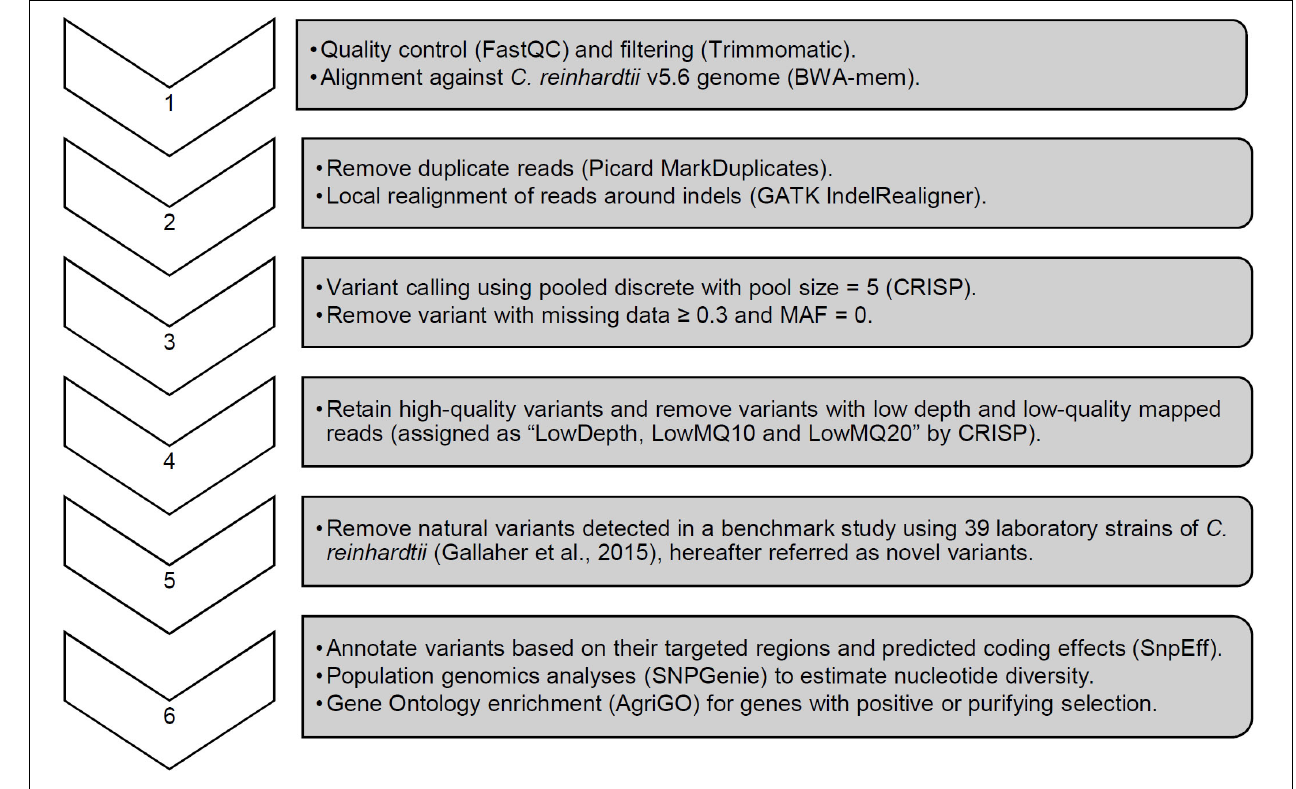
FIGURE 4 | Sequence analysis pipeline with key parameters for variant calling and quality filtering.